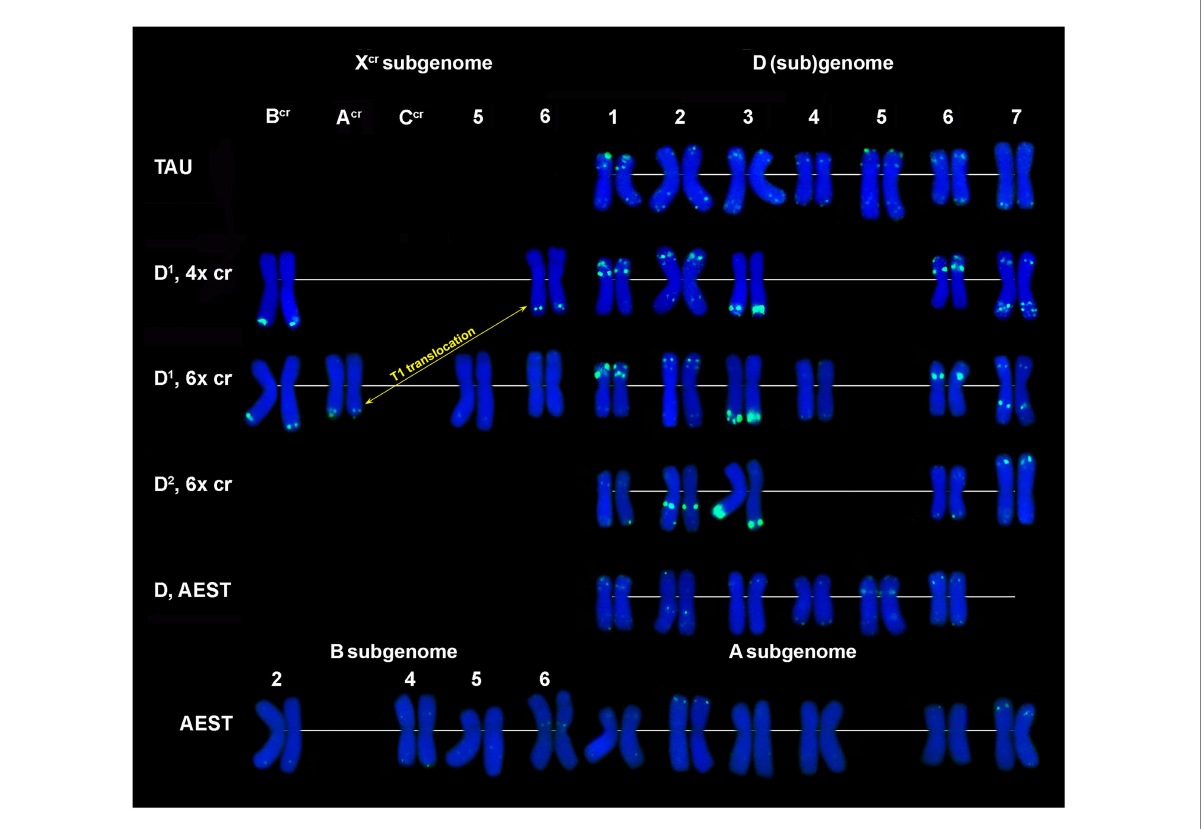
FIGURE 6 Comparison of CL228 labeling patterns on chromosomes of different cereal species: TAU – Ae . tauschii ssp. strangulata; D 1 , 4x cr – D 1 subgenome of tetraploid Ae . crassa ; D 1 , 6x cr, D 2 , 6x cr – D 1 and D 2 subgenomes of hexaploid Ae . crassa; AEST – A, B, and D subgenomes of T . aestivum . 1–7 – homoeologous groups. White arrowheads show minor CL228 sites detected on the X cr , A, B, and D subgenome